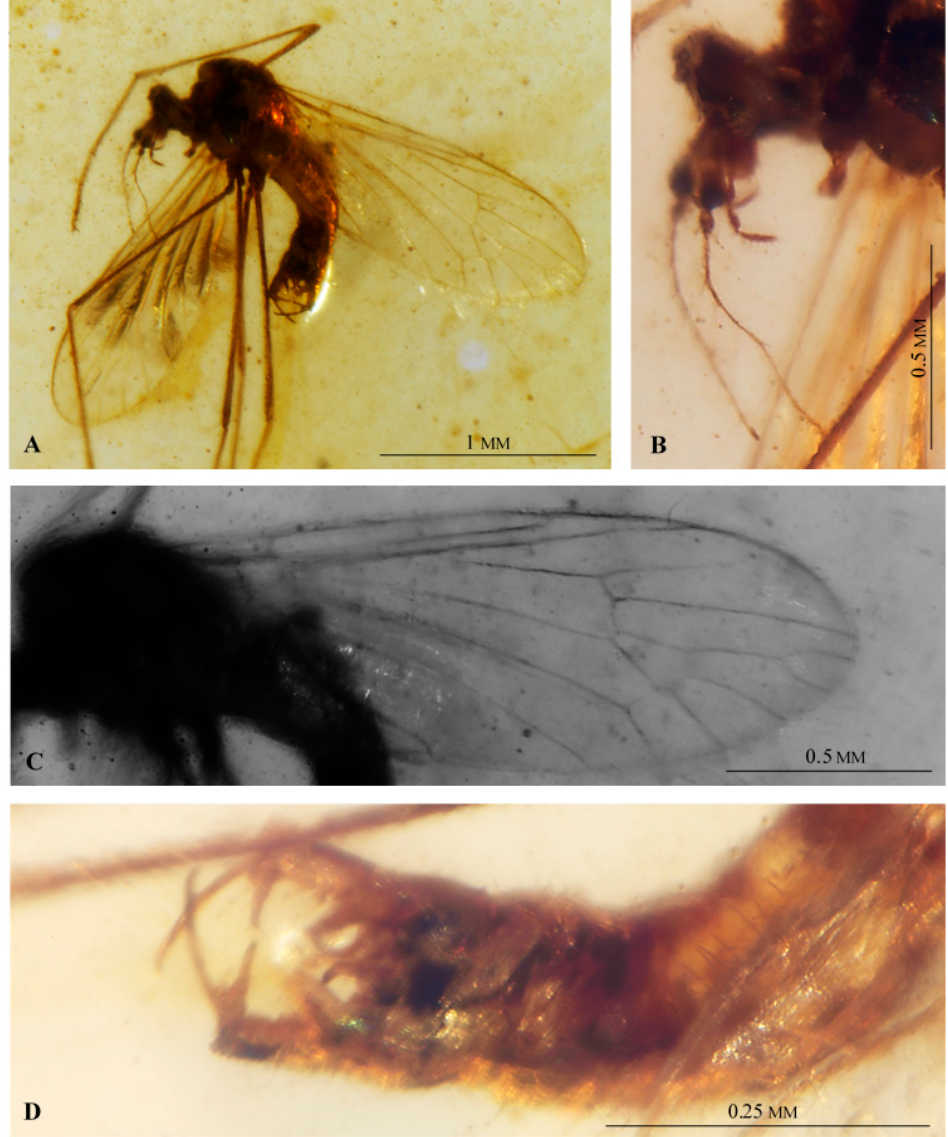
Figure 7. Decessia podenasi gen et sp. nov. No. MP/4067 holotype (male) (ISEA PAS). ( A ) body, latero-ventral view; ( B ) head, lateral view; ( C ) wing venation; ( D ) hypopygium and last segments of abdomen, ventral view.